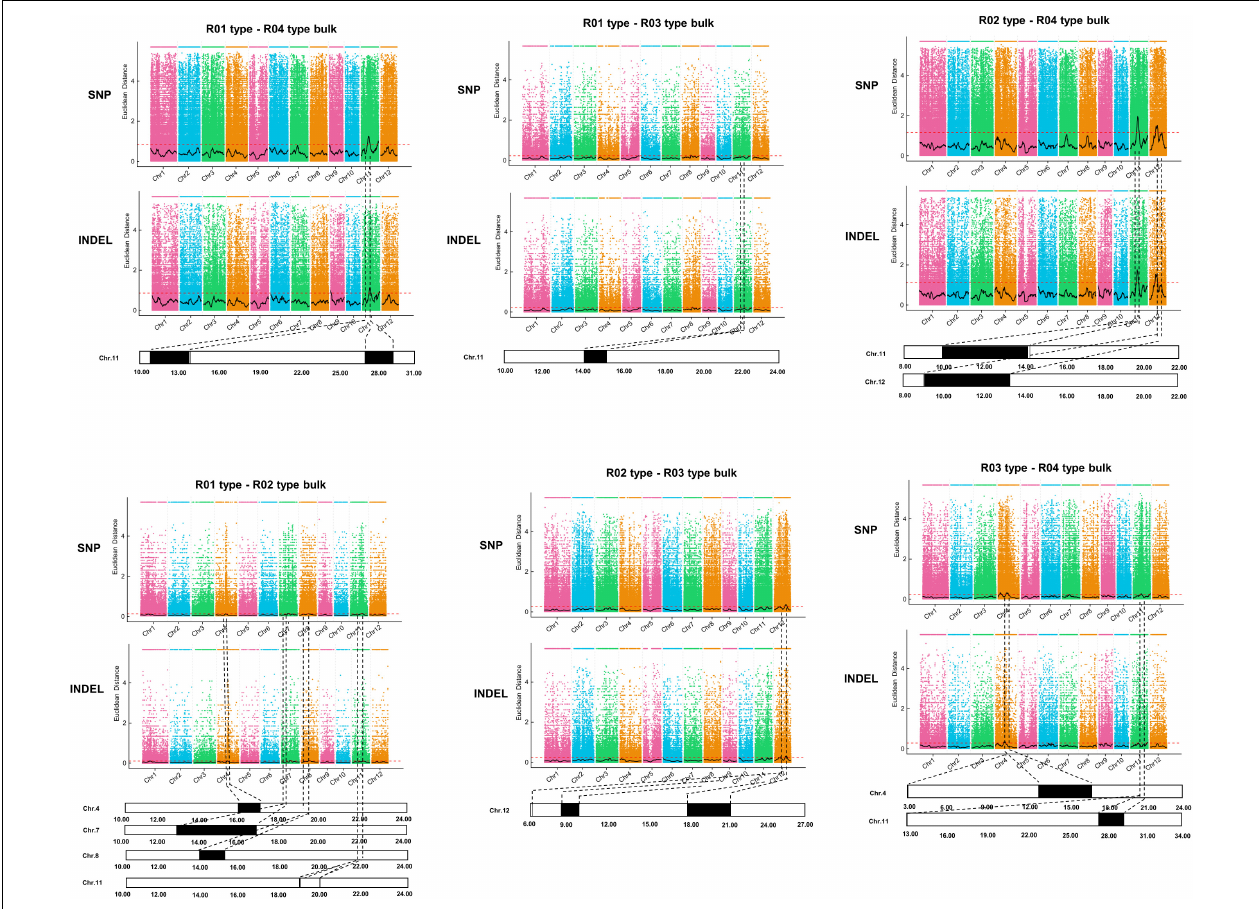
FIGURE 3 | Identification of genomic regions controlling plant architecture in the Guiping wild rice population according to the PCAMP data. Four plant architecture types: R01-erect, R02-semi-erect, R03-tilted, and R04-creeping. Thirty individuals were selected for each type to construct a mixed DNA pool. A bulked segregant analysis was performed for each type. The Euclidean distance (ED) value of SNPs and InDels was calculated to identify the candidate regions for each comparison. The overlapping physical positions on the same chromosome for each comparison are in black.